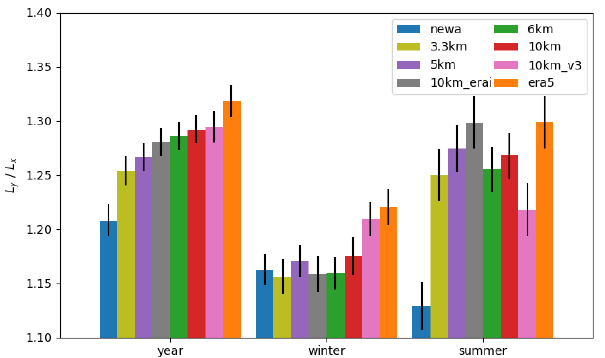
Figure 10. Ratio of simulated and observed characteristic length scales L Y /L X , both parameters fitted from curves in Fig. 8, and the standard error of the estimated parameters (bars). Winter refers to months January–March; summer refers to July–September. L > 1 means that simulations overestimate the parameter L